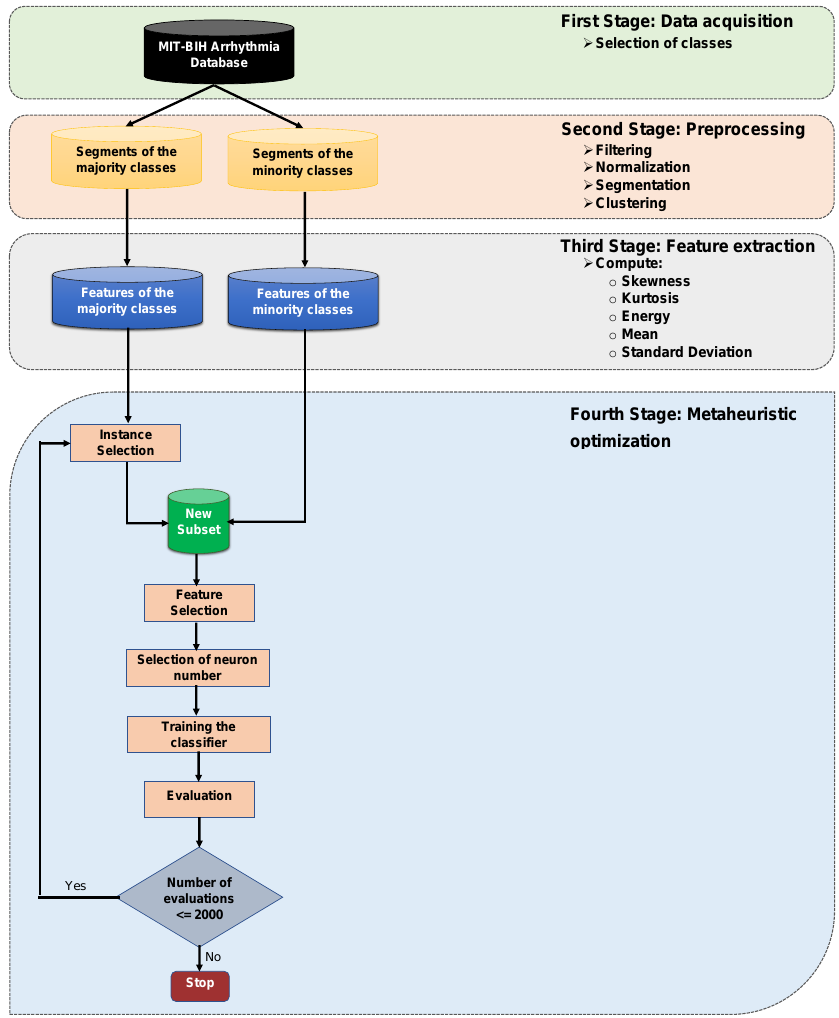
Figure 2. Metahuristic approach